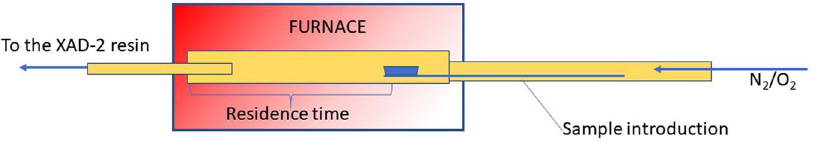
Figure 1. Schematic diagram of the batch laboratory scale tubular reactor used in the different studies on the decomposition of